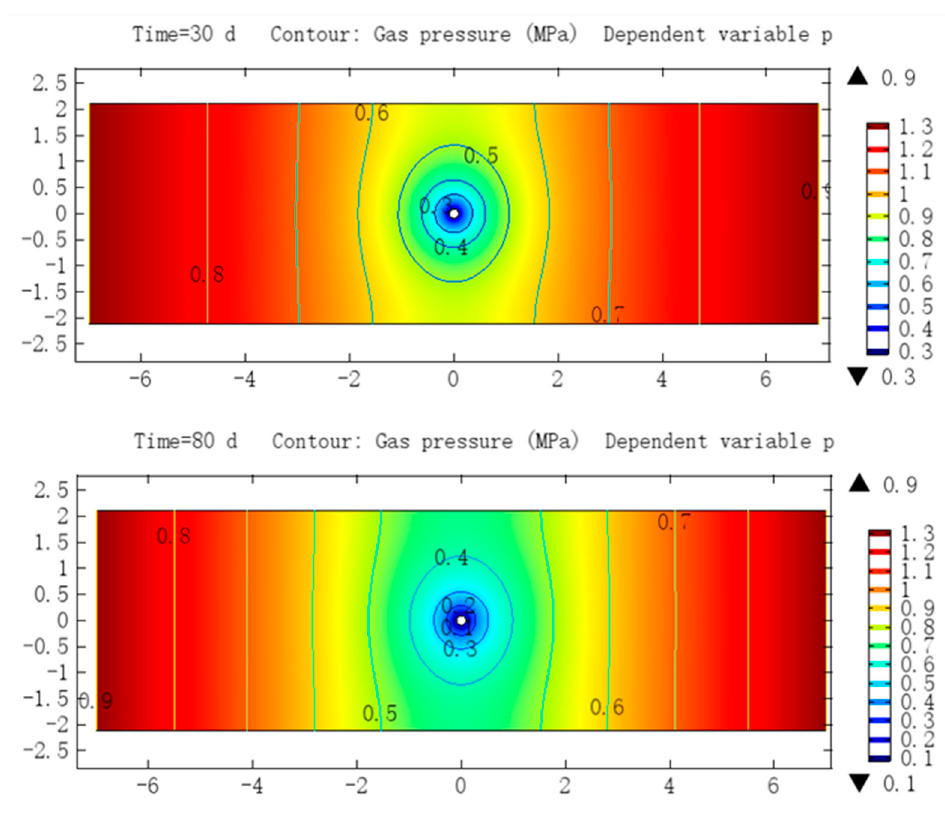
Figure 6. Contour maps of gas pressure at di ff erent times.